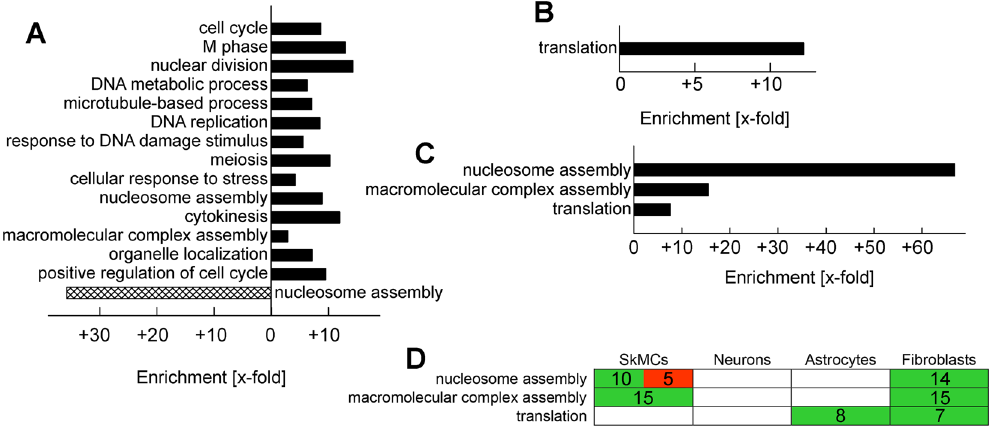
Figure 3. Biological processes differentially or commonly enriched in the T. gondii -regulated transcriptomes of mature SkMCs, neurons, astrocytes and fibroblasts. After genome-wide expression profiling, T. gondii -regulated host cell genes (at least 2-fold up- or downregulation; p < 0.05) were screened for annotation terms being overrepresented as compared to the reference genome to identify biological processes being regulated after infection (FDR < 0.05, modified Fisher exact test with Benjamini-Hochberg correction for multiple testing). Redundant annotation terms were omitted. ( A ) Annotation terms that are overrepresented among genes up- (black bars) or downregulated (cross-hatches bars) in SkMCs by T. gondii -infection. ( B ) Annotation term that is overrepresented among genes upregulated in astrocytes by T. gondii -infection. ( C ) Annotation terms that are overrepresented among genes upregulated in fibroblasts by T. gondii -infection. ( D ) Impact of T. gondii infection on biological processes being enriched in at least two cell types following infection. Up- and downregulation of genes related to the biological processes as indicated are depicted in green or red , respectively. Figures indicate the numbers of genes the expression of which is regulated in the respective cell types.